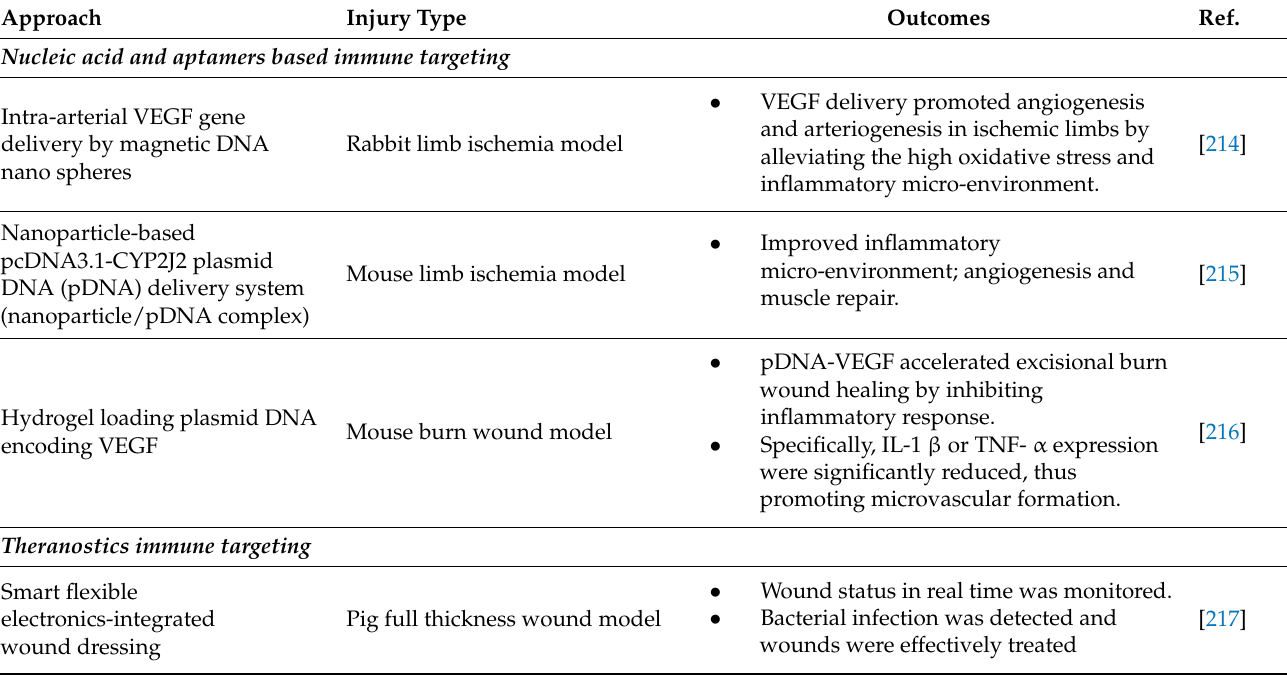
Table 3. Summary of selected immune engineering approaches to promote wound